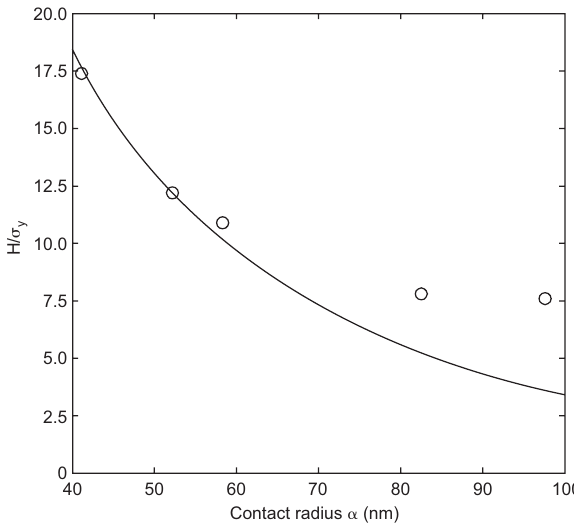
Figure 3 Variation of reduced hardness H / σ the contact radius a . Experimental measurements in [10] are rep- resented with open circles, while theoretical predictions based on Eq. (23) are represented with a continuous